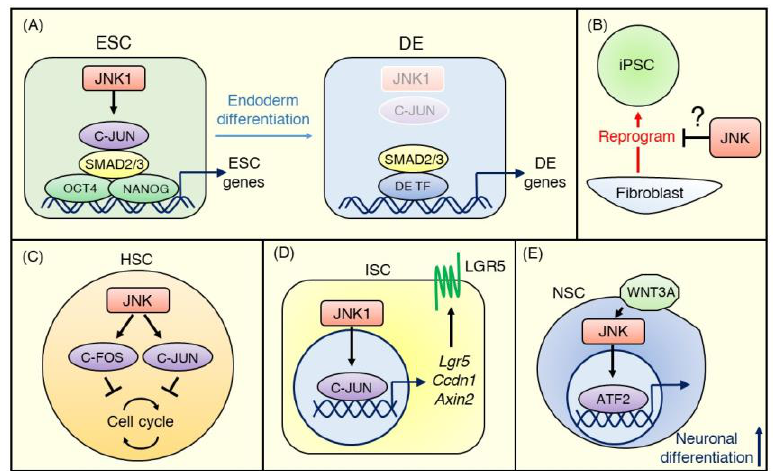
Figure 3. JNK signaling in normal stem cells. ( A ) In embryonic stem cells (ESCs), the JNK pathway inhibits definitive endoderm (DE) di ff erentiation and maintains the undi ff erentiated status.